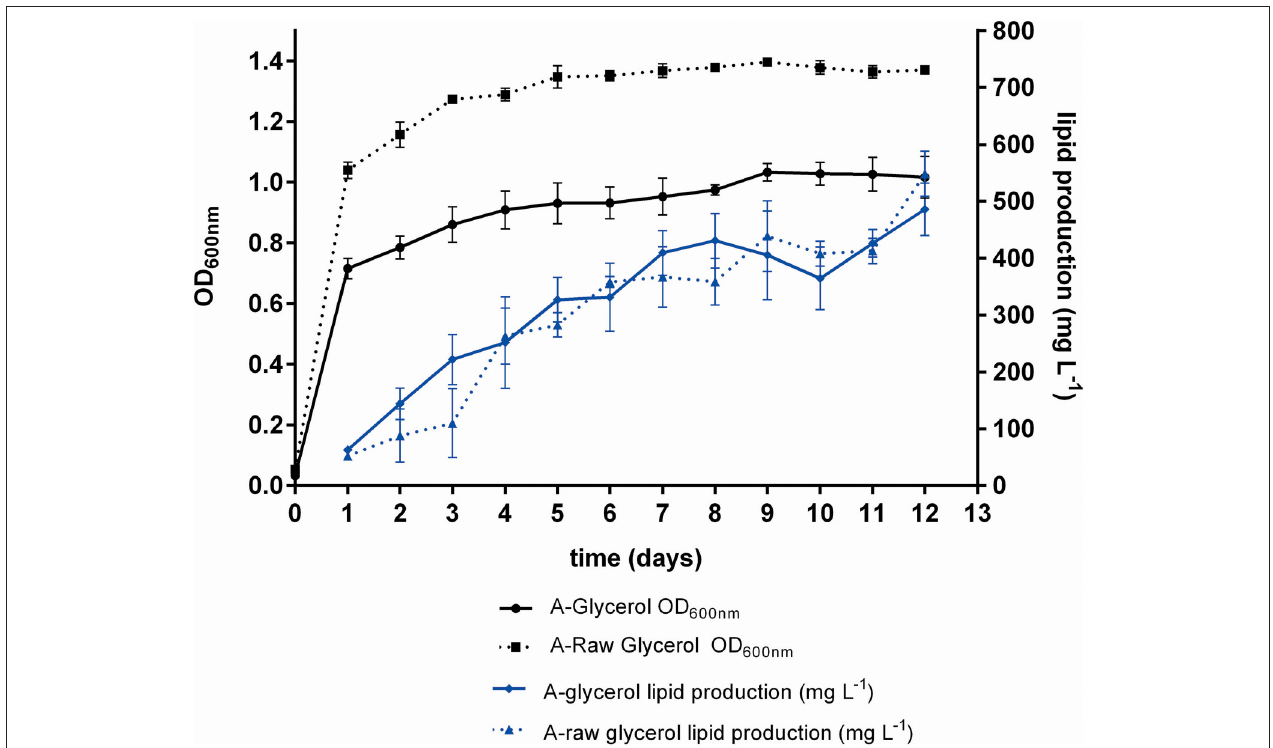
FIGURE 5 | Growth curve (OD600 nm) and kinetics of lipid production (mg/L) of M. guilliermondii BI281A. The solid lines indicate pure glycerol and dotted lines indicate raw glycerol. The experiments were measured in biological triplicate (average ± standard deviation) for 12 days. Samples in 5 and 12th day were taken for lipid extraction, transesterification and